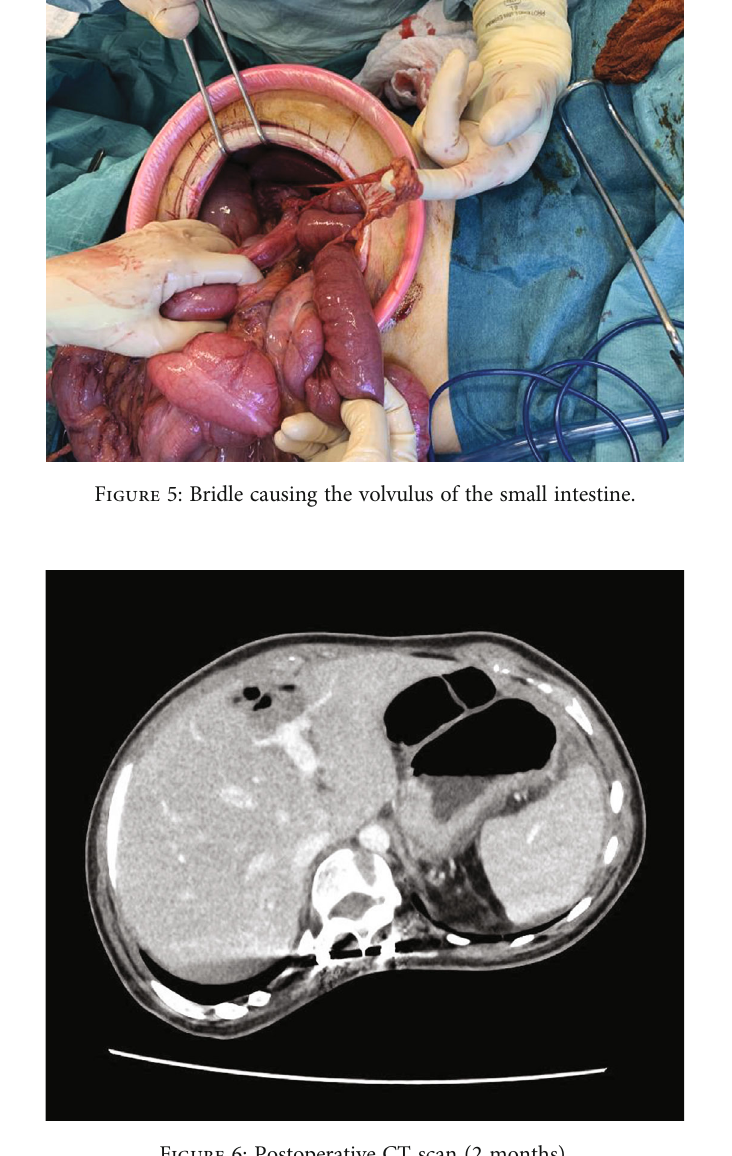
Figure 6: Postoperative CT scan (2